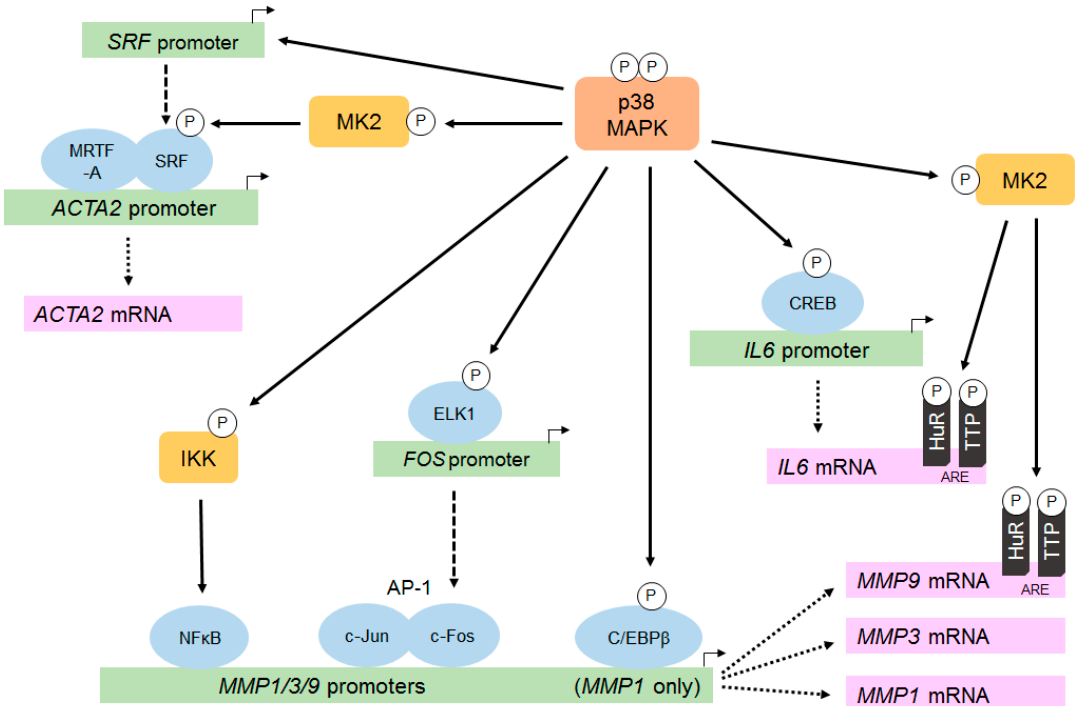
Figure 2. Molecular mechanisms by which p38 regulates the expression of MMPs, α SMA and IL-6 in cardiac fibroblasts. The p38 pathway is important for upregulating the expression of specific proteins in cardiac fibroblasts, including matrix metalloproteinases (MMPs), α -smooth muscle actin ( α SMA / ACTA2) and interleukin-6 (IL-6). Modulation occurs at multiple levels, including the regulation of gene transcription and mRNA stability. P38 activation leads to phosphorylation and activation of specific transcription factors (via both direct and indirect mechanisms), and can also increase stability of specific mRNAs through the phosphorylation of mRNA stabilizing factors (e.g., HuR) and mRNA destabilizing factors (e.g., TTP). See main text for more